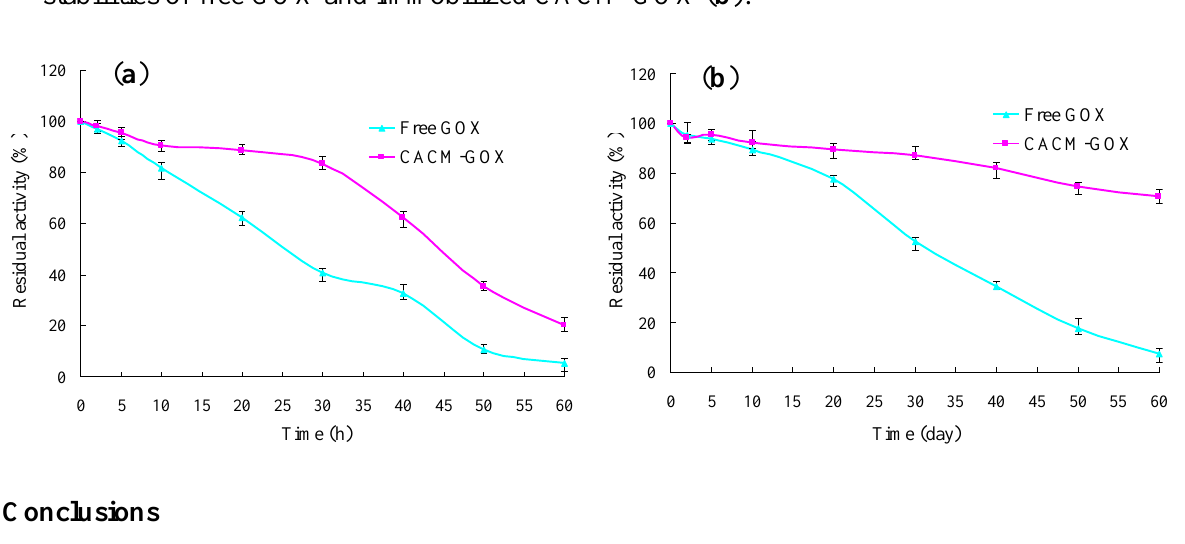
Figure 8. Thermal stabilities of free GOX and immobilized CACM-GOX ( a ) and storage stabilities of free GOX and immobilized CACM-GOX ( b